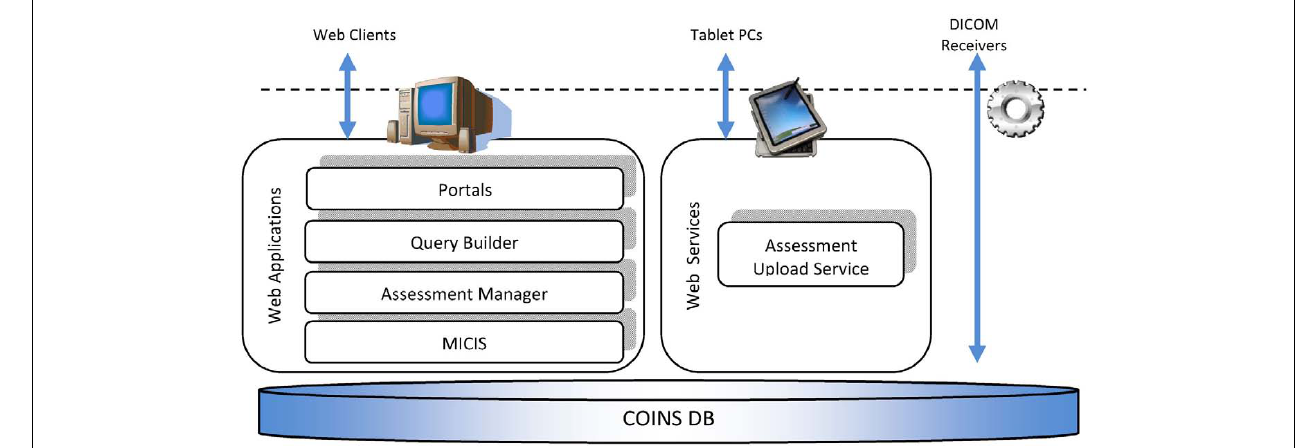
FIGURE 2 | Overview of COINS.